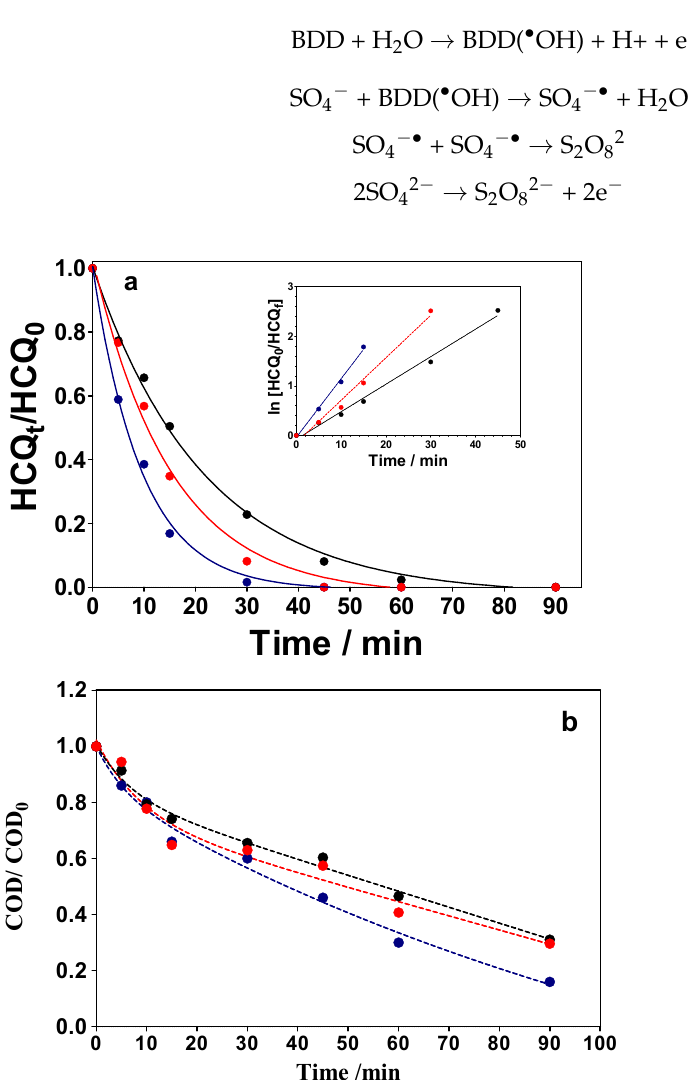
Figure 3. Effect of j : ( • ) 15, ( • ) 30 and ( • ) 45 mA cm − 2 on the abatement of 26.8 mg L − 1 of HCQ in an acidic river water matrix with H 2 SO 4 : ( a ) normalized HCQ concentration decays ([HCQ] t /[HCQ] 0 at time t and t = 0 (in min) considering an initial HCQ concentration of 26.87 mg L − 1 , as electroana- lytically determined by DPV approach with cork-graphite sensor at 25 ± 2 °C). Inset: Decay kinetic analysis assuming pseudo-first order reaction. ( b ) COD decay, over time in min.